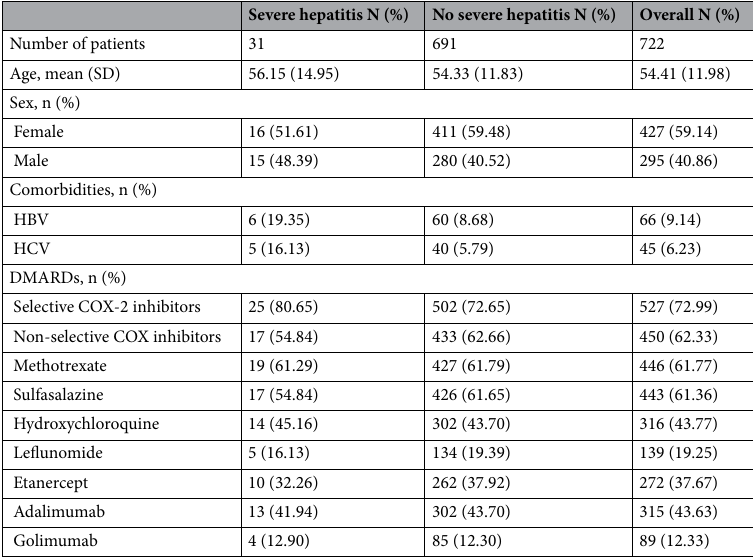
Table 1. Characteristics of TNFi users with RA or AS receiving isoniazid treatment with and without severe hepatitis. Comorbidities (HBV, HCV) were defined as diagnosed between 2003 and 2015. Co-medications were defined as co-prescription with INH during same period. Severe hepatitis: the diagnosis of the inpatient claims data with ICD-9-CM 570, 573.3, 573.8, 573.9.